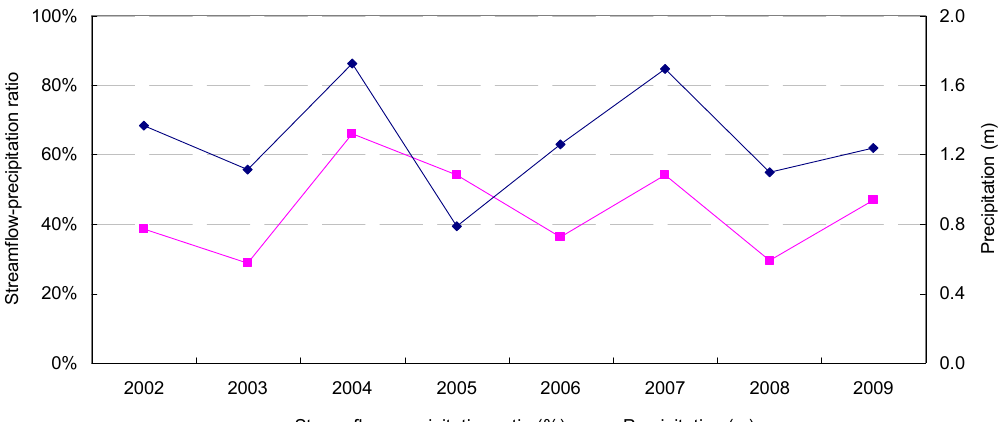
Figure 10. Annual streamflow-precipitation ratio and precipitation depth of Site 2 (Bear Creek watershed, conventional development),